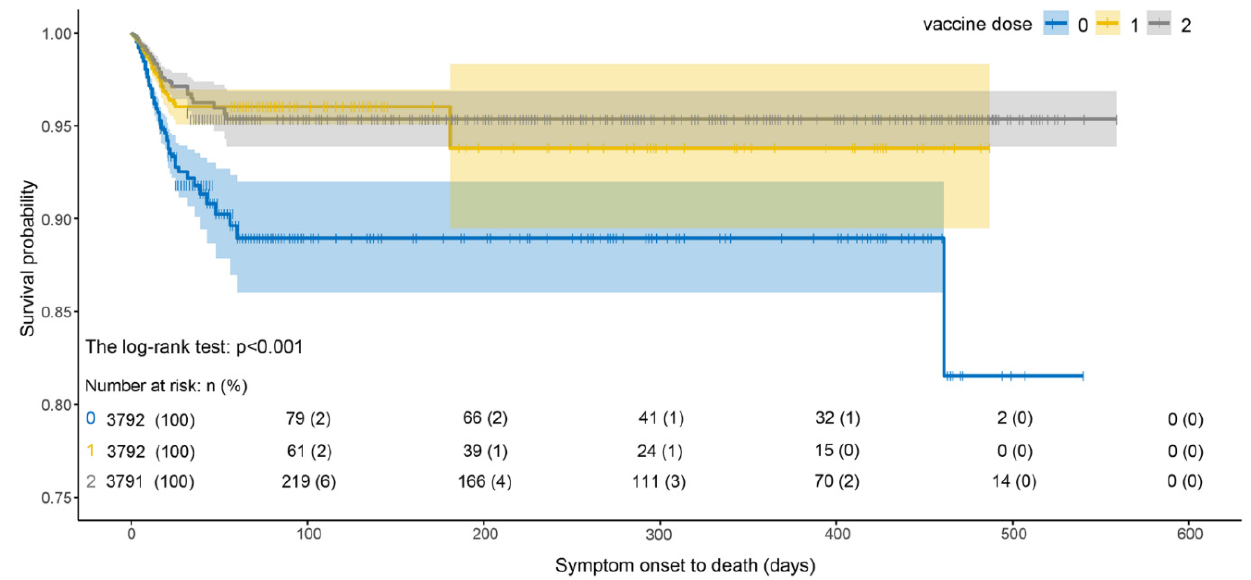
Figure 6. Survival curves of SOD estimated by Kaplan–Meier estimator under different vaccine doses.